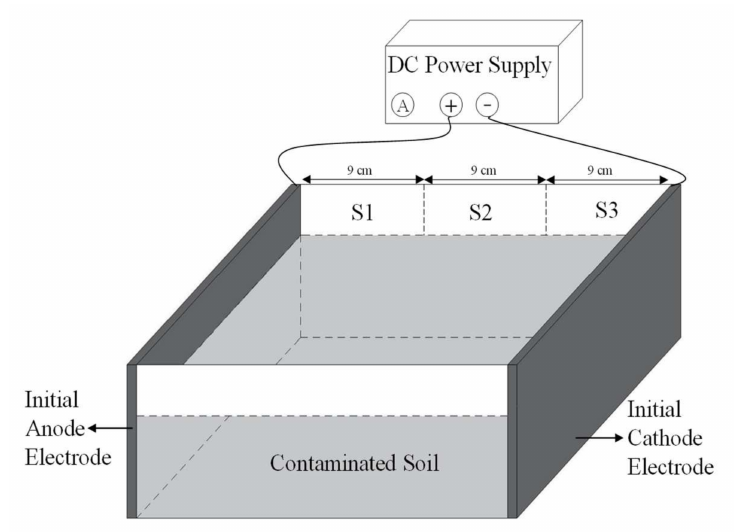
Figure 1. The electrokinetic remediation experiment diagram.